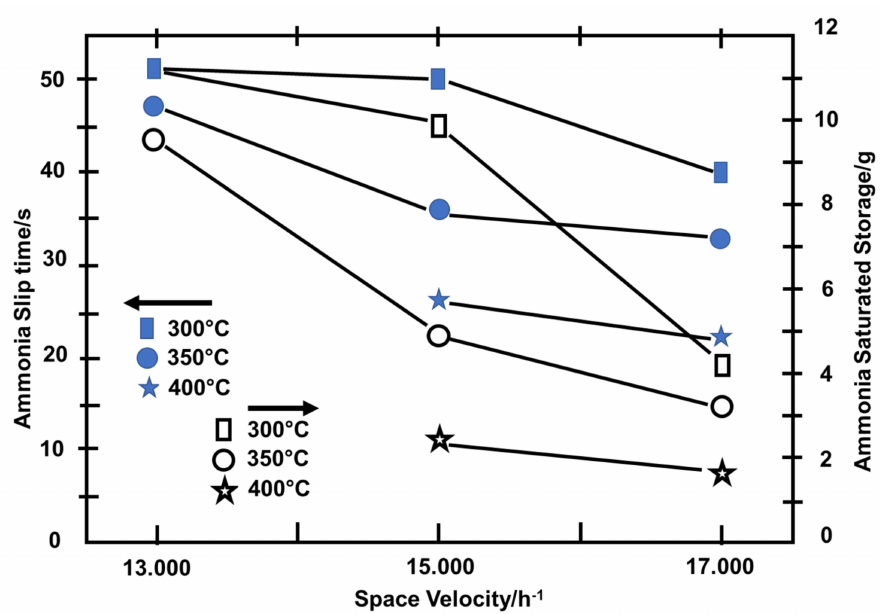
Figure 7. Ammonia slip time and saturation storage, as well as the change in space velocity at various catalyst temperatures